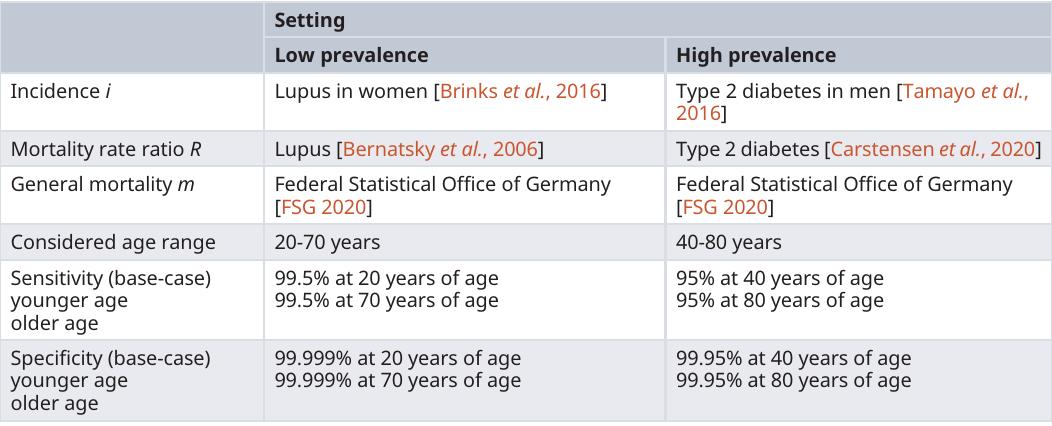
Table 1. Description of the parameter settings in the